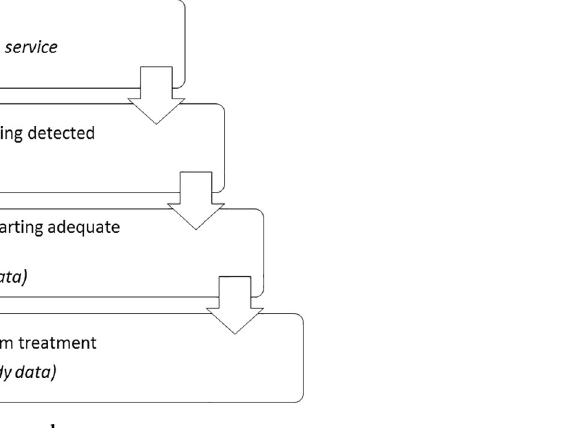
Fig 1. PRIME Nepal evaluation